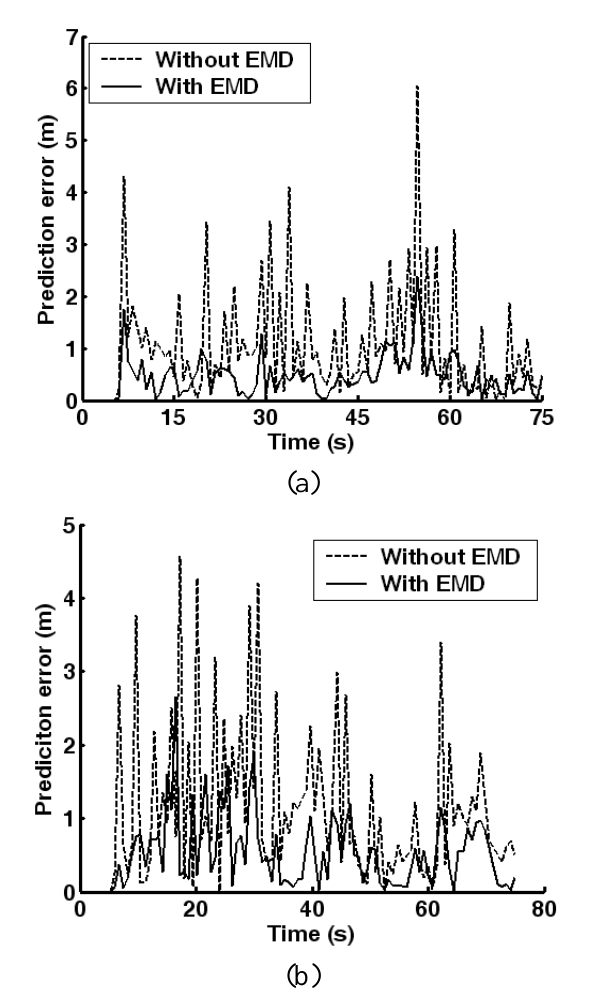
Figure 10. Comparison of forecasting error with and without EMD for time series after differentiation: (a) X direction; (b) Y direction.